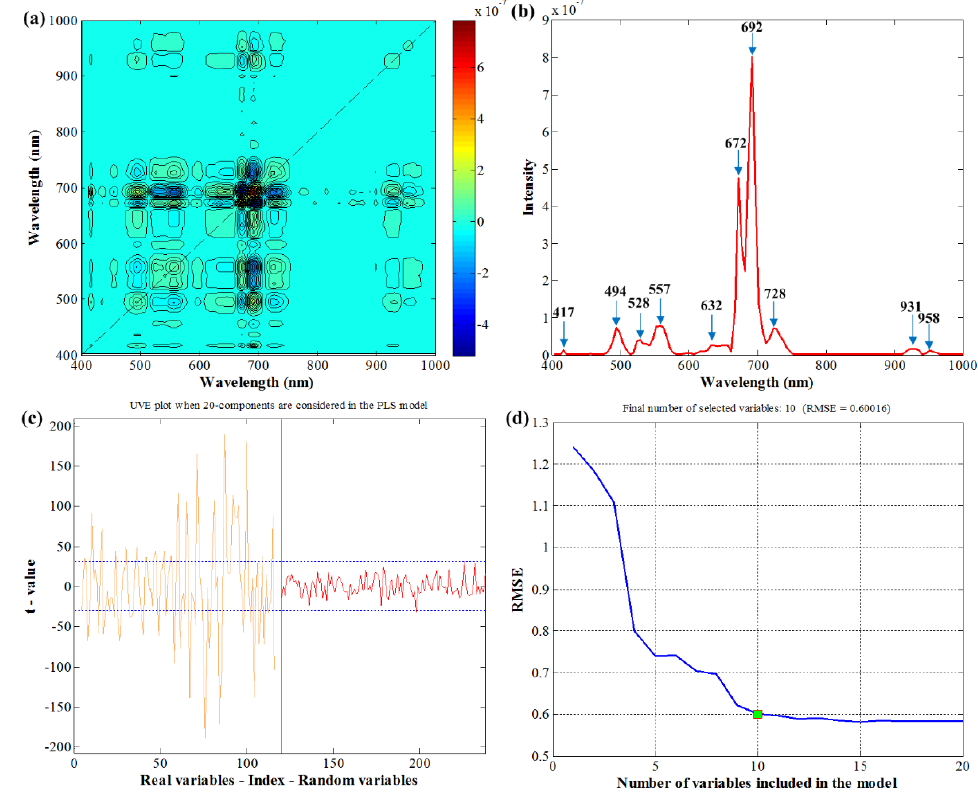
Figure 7. Wavelengths selection steps. ( a ) The synchronous 2D correlation spectra; ( b ) spectrum in a diagonal line in synchronous 2D correlation spectra; ( c ) the stability of wavelengths and random variables in UVE; ( d ) the changing trend of RMSE with the increase in selected wavelengths by SPA. 2D, two-dimensional; RMSE, root mean squares error; SPA, successive projections algorithm. Table 3. Wavelength selection by different methods.